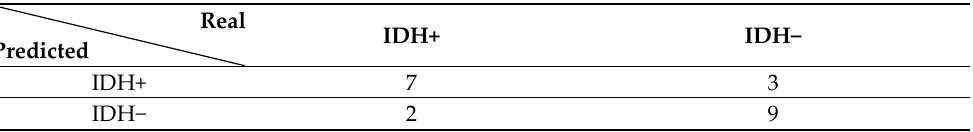
Table 2. Contingency table between imunohistochemistry/molecular IDH status (Real) and its algorithm prediction (Predicted).